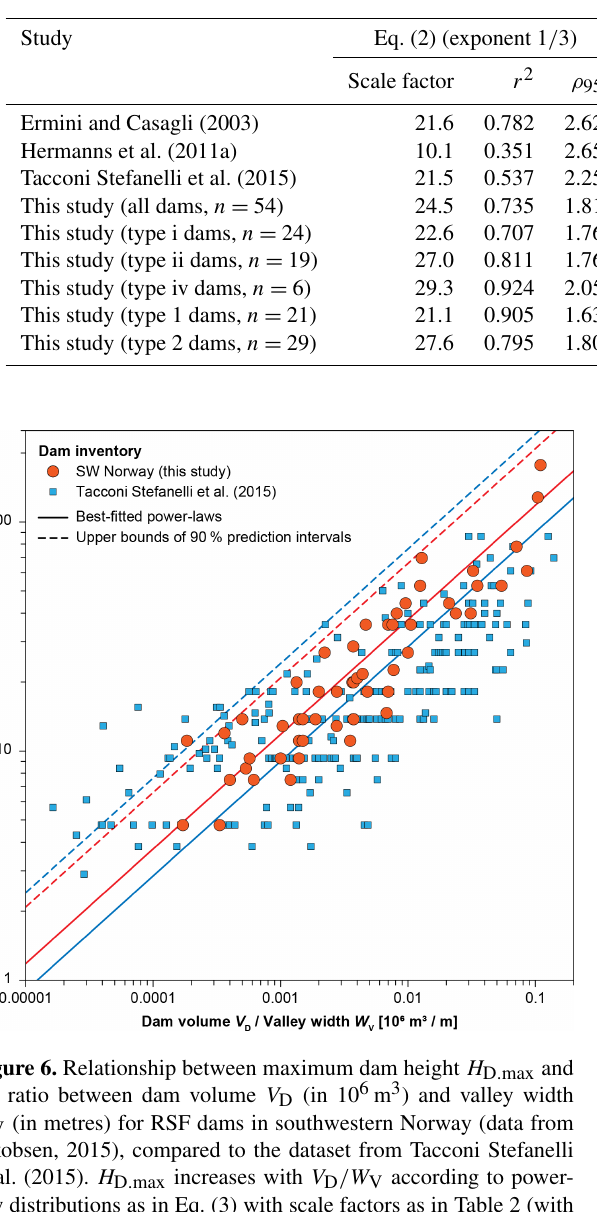
Table 2. Fitting parameters of the semi-empirical relations for different studies.